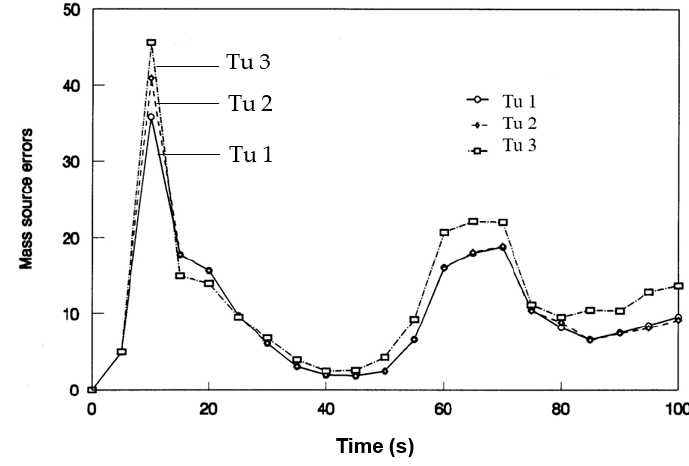
Figure 5. Comparison of the time dependence of mass source errors.